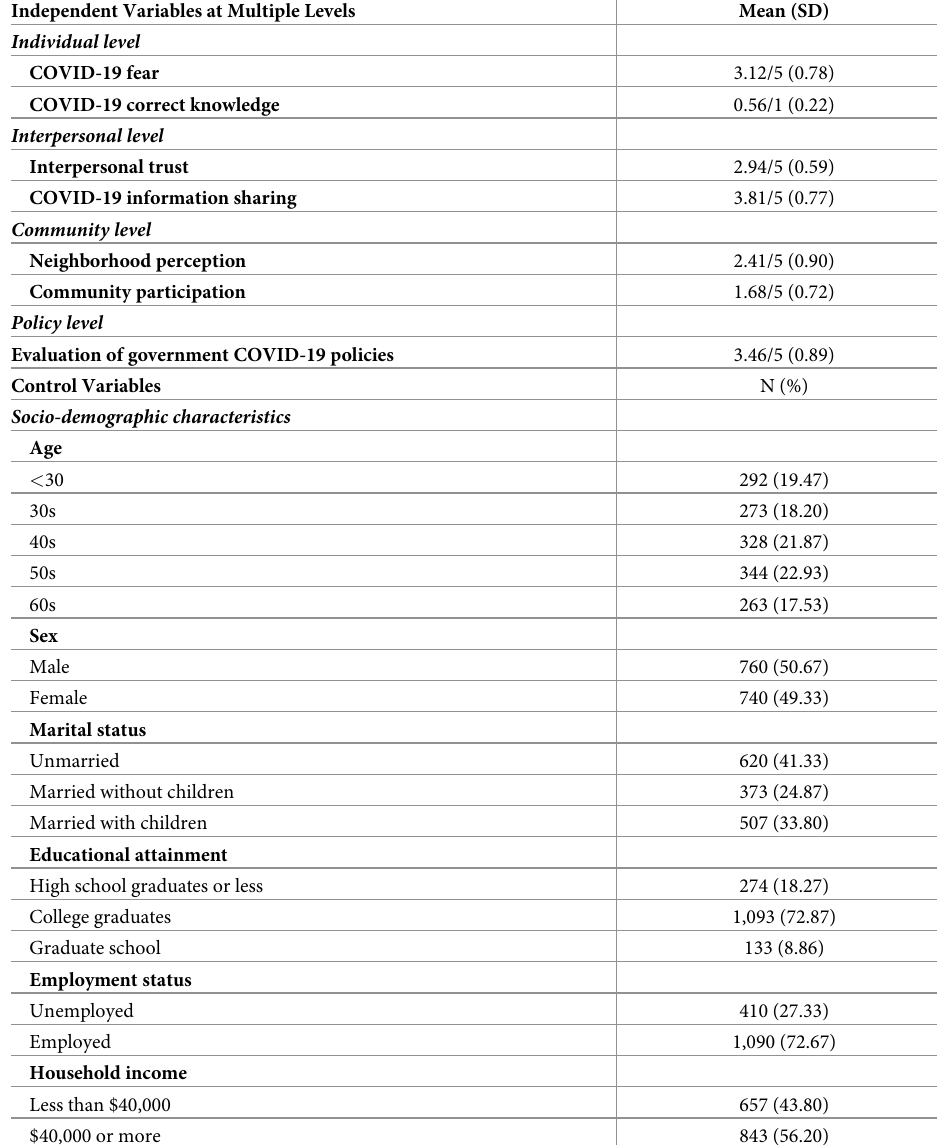
Table 1. Characteristics of the survey participants (N =